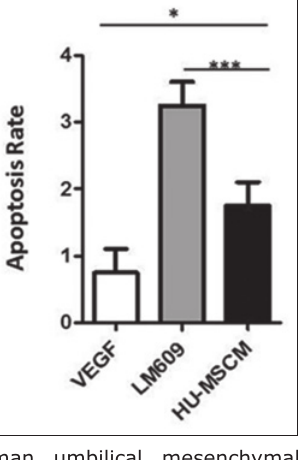
Figure-3: Human umbilical mesenchymal stem cells conditioned medium (HU-MSCM) could decrease apoptosis rate. Vascular endothelial growth factor (VEGF) (white bar), monoclonal antibodies (mAbs) clone LM609 (gray bar), in concentration 20 μ g/ml and HU-MSCM (black bar) was added to endothelial cells and caspase 3/7 activity was measured by luminometry (upper panel). Some experiments were performed in the presence of lipopolysaccharide. Statistical analysis was performed by one-way ANOVA followed by Bonferroni’s post-hoc test; VEGF = Control negative for apoptosis, mAbs against α v β 3 clone LM 609 was used as positive control.